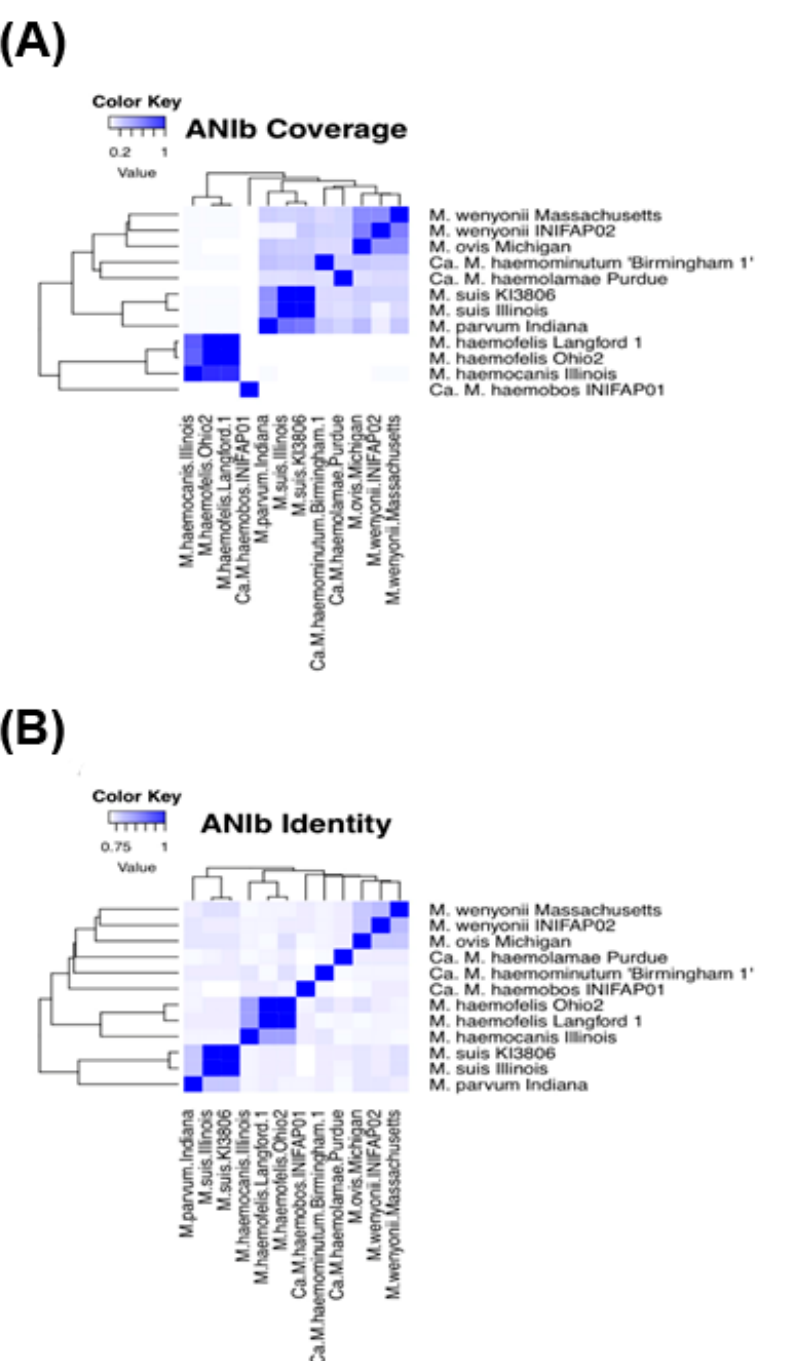
Figure 4. Heatmaps of blast-based average nucleotide identity (ANIb) values of 12 hemoplasma genomes. ( A ) Heatmap of ANIb values of alignment coverage. ( B ) Heatmap of ANIb values of identity. Color intensity increases from white to deep blue when ANIb values approach from 0.0 to 1.0 (0–100%), respectively. The more intense the color, the greater the coverage and identity percentages.